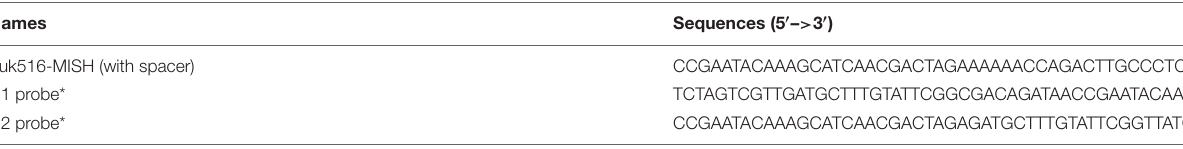
TABLE 1 | Sequences and probes used in the